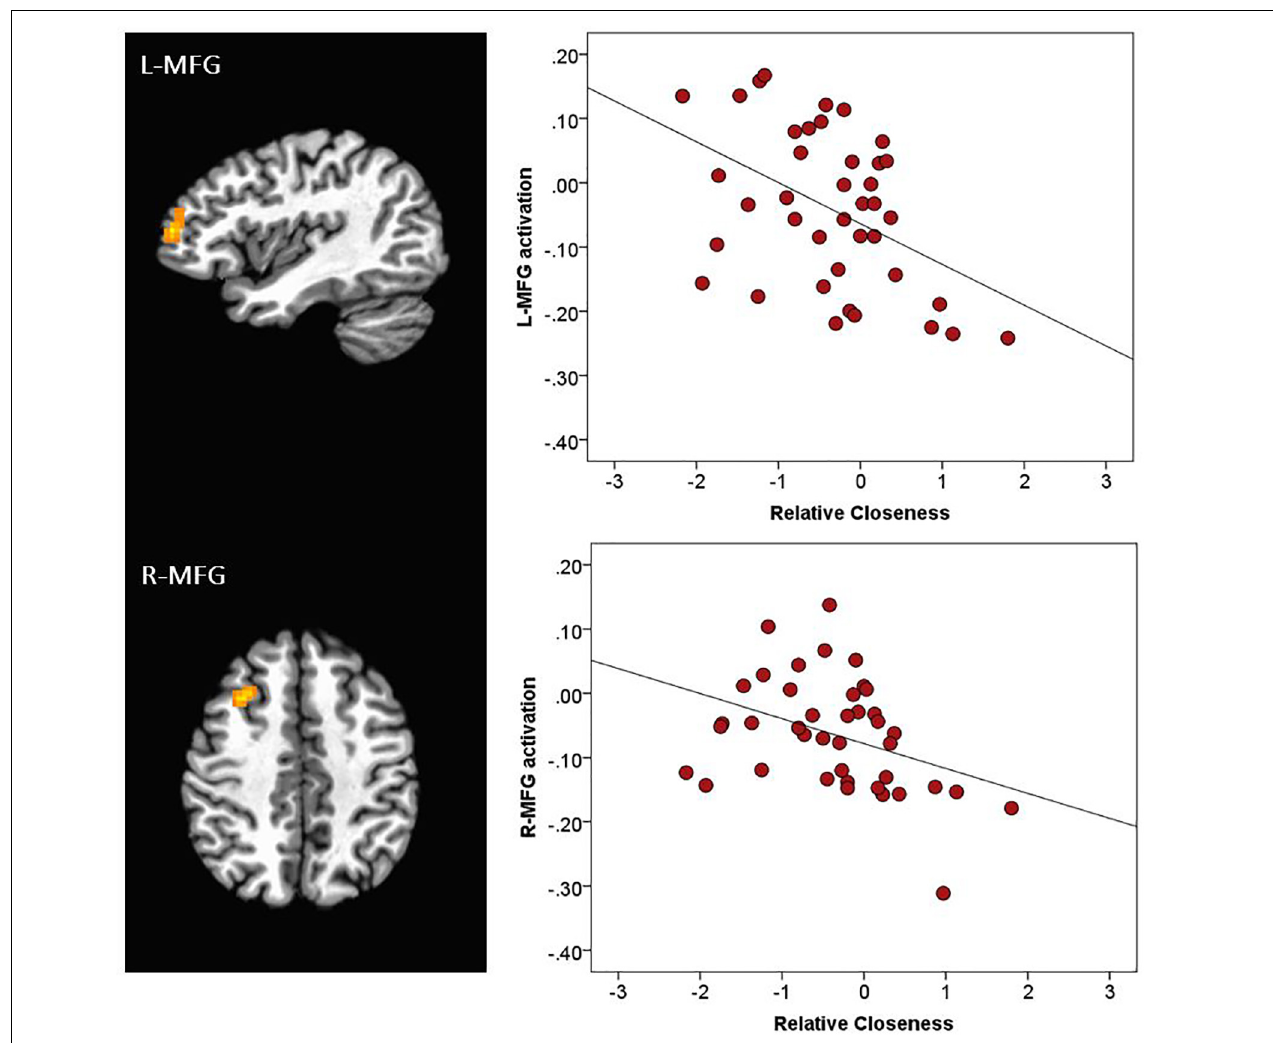
FIGURE 4 | Activation during stimulus presentation associated with participants’ relative closeness with peers over parents. R, right; L, left. MFG, middle frontal gyrus. Clusters were formed using 3dclustsim at p < 0.001, with a cluster size threshold of 27 voxels. Brain images are rendered in the Talairach-Tournoux template space. Refer to Table 2 for description of regions of activation. The black line on the scatterplots represents the linear relationship between neural activation and Relative Closeness (L-MFG: R 2 = 0.20; R-MFG: R 2 =